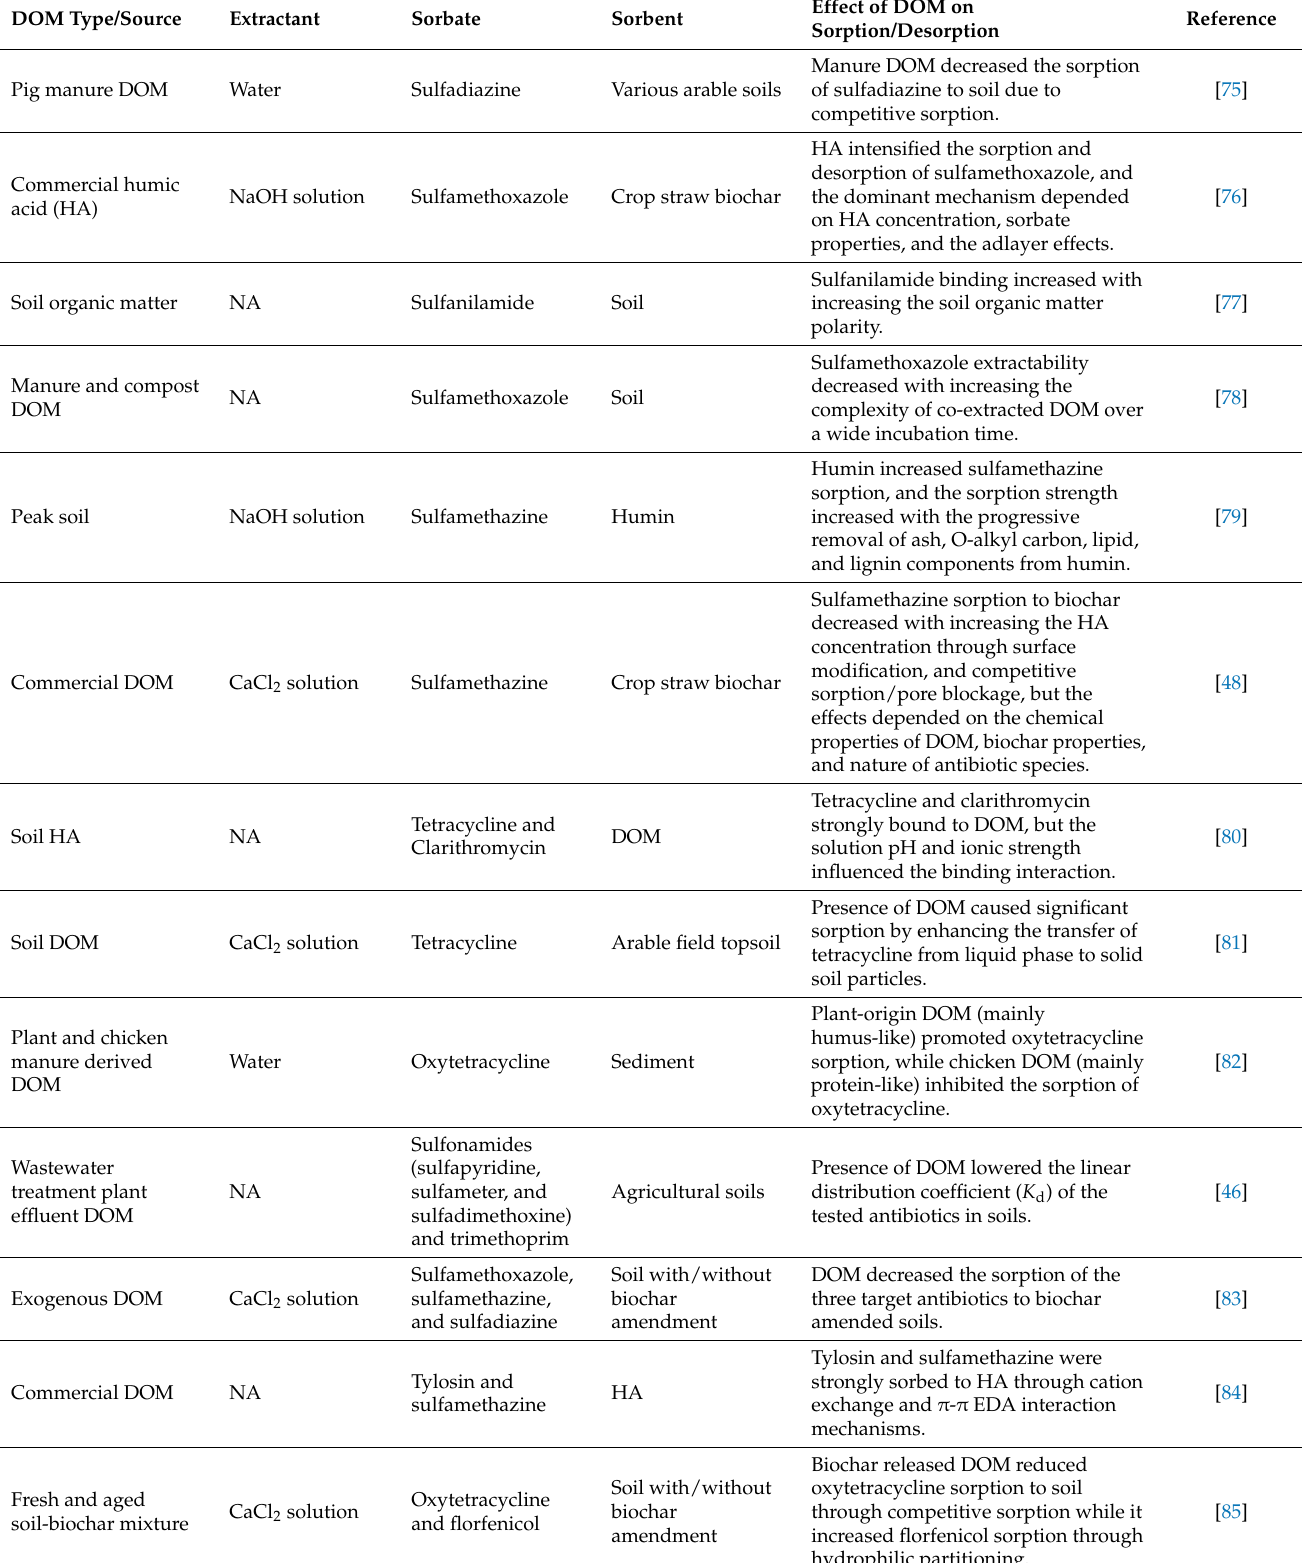
Table 1. Effects of various DOM on sorption − desorption of VAs in